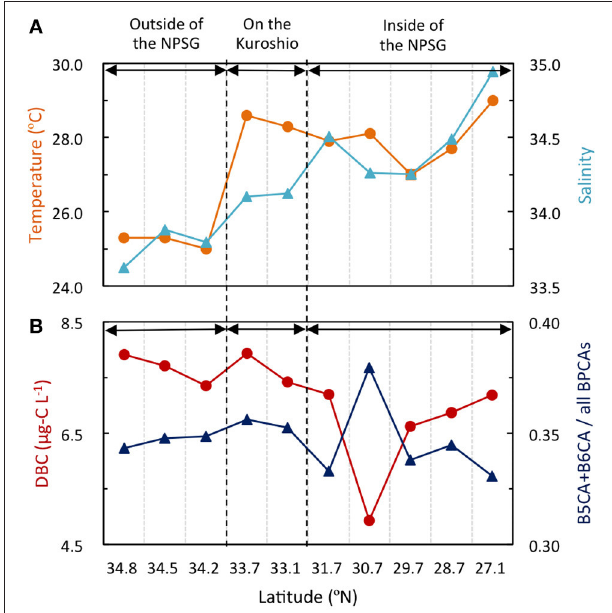
FIGURE 6 | Distributions of salinity and temperature (A) and concentration and condensation degree (ratio of B5CA and B6CA to all BPCAs) of DBC (B) in surface waters of the subtropical North Pacific. The outside of the North Pacific Subtropical Gyre (NPSG) is close to